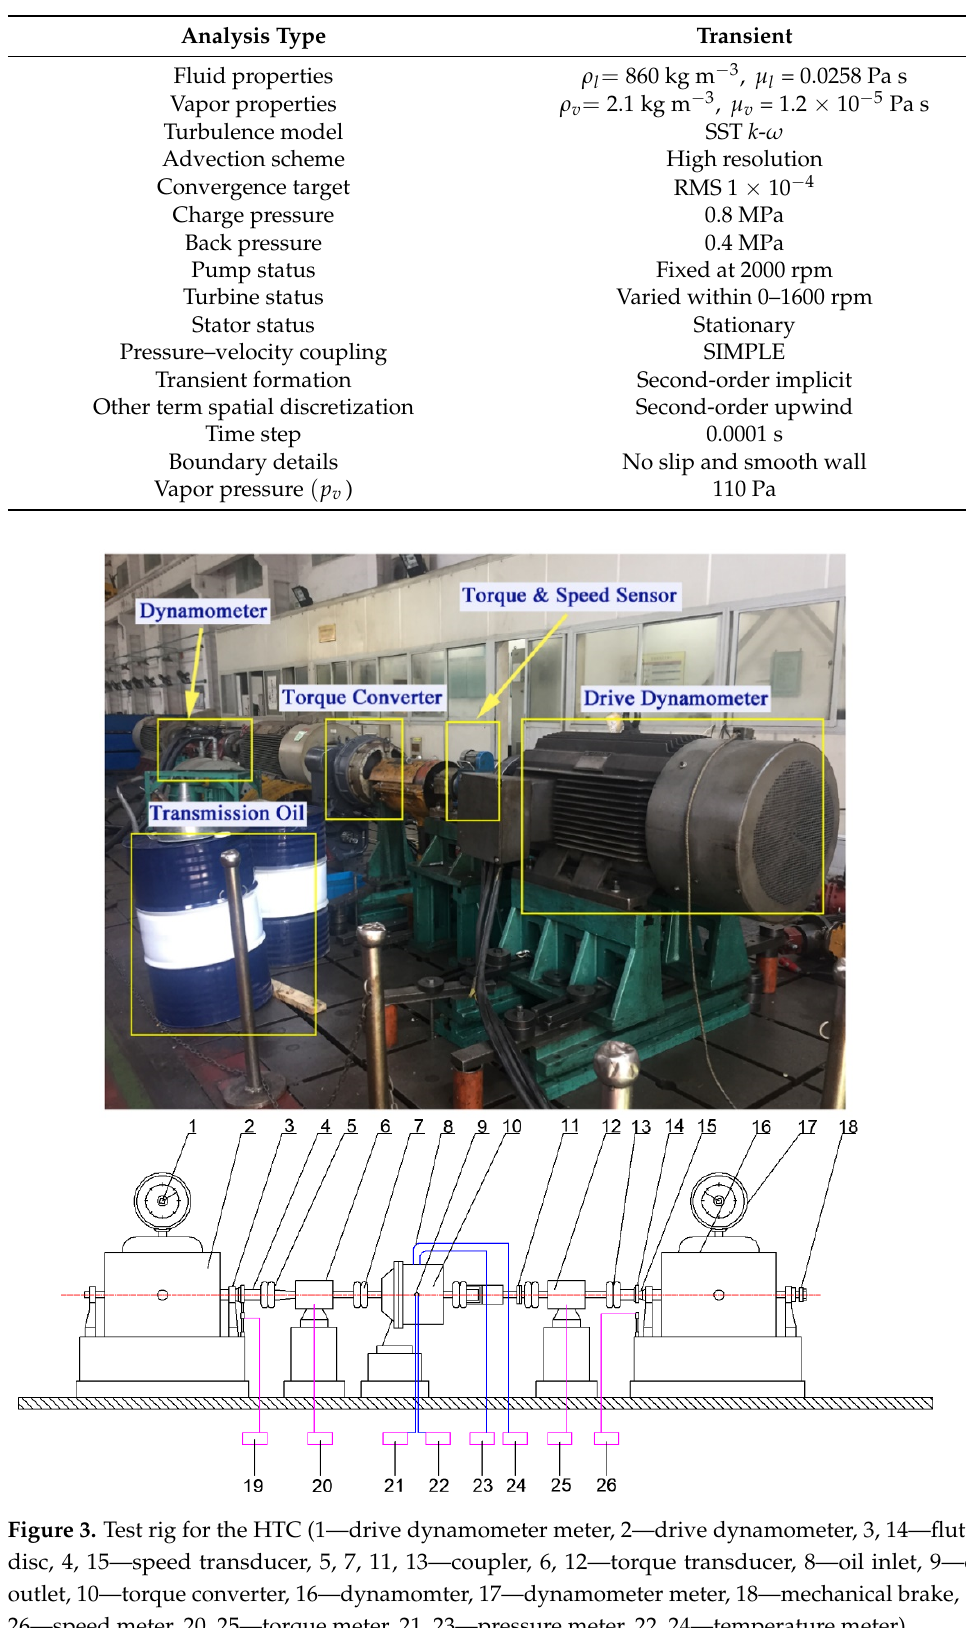
Table 2. Detailed CFD model parameter setting.